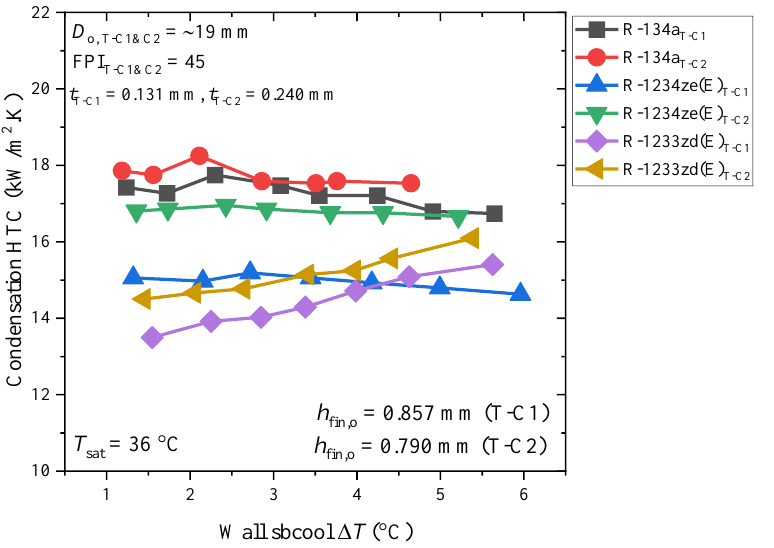
Figure 5. Influence of fin thickness on condensation HTCs of R-134a, R-1234ze(E), and R-1233zd(E) Ji et al. [10].